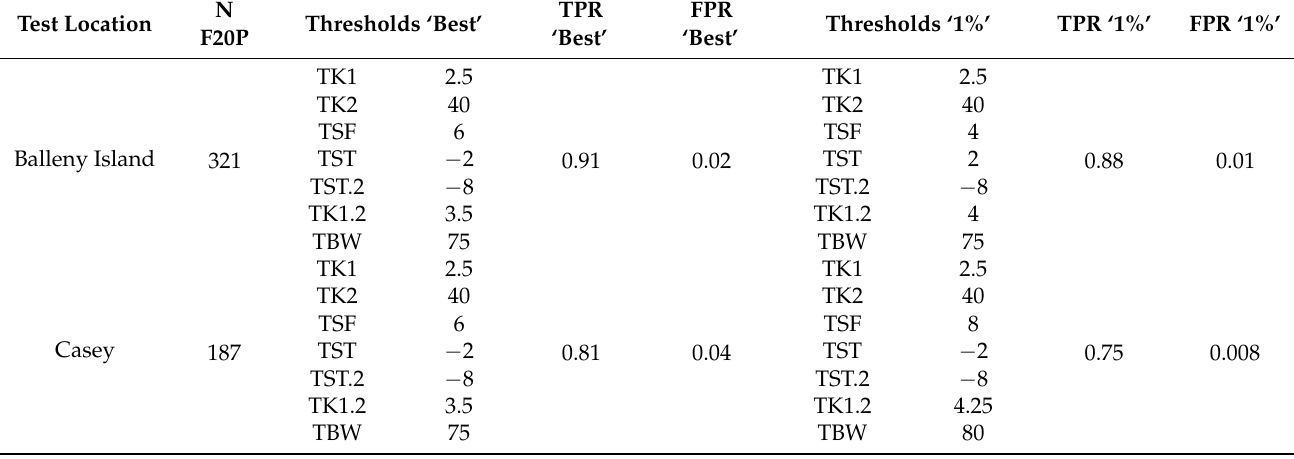
Table 2. Results of the blocked cross-validation between locations for the F20P detection algorithm. Blocks are the combined locations excluding the respective test location. The table provides the number of F20P in the dataset of the test location (N F20P), the threshold combination that yielded the ‘best’ result in each block (i.e., values closest to a true positive rate of 1 and a false positive rate of 0; Thresholds ‘Best’), the resulting true positive rate for the test location (TPR ‘Best’), the resulting false positive rate for the test location (FPR ‘Best’), the threshold combination that yielded the high- est true positive rate at a false positive rate ≤ 1% in each block (Thresholds ‘1%’), the resulting true positive rate for the test location (TPR ‘1%’), and the resulting false positive rate for the test location (FPR ‘1%’). − 2 TST − 2